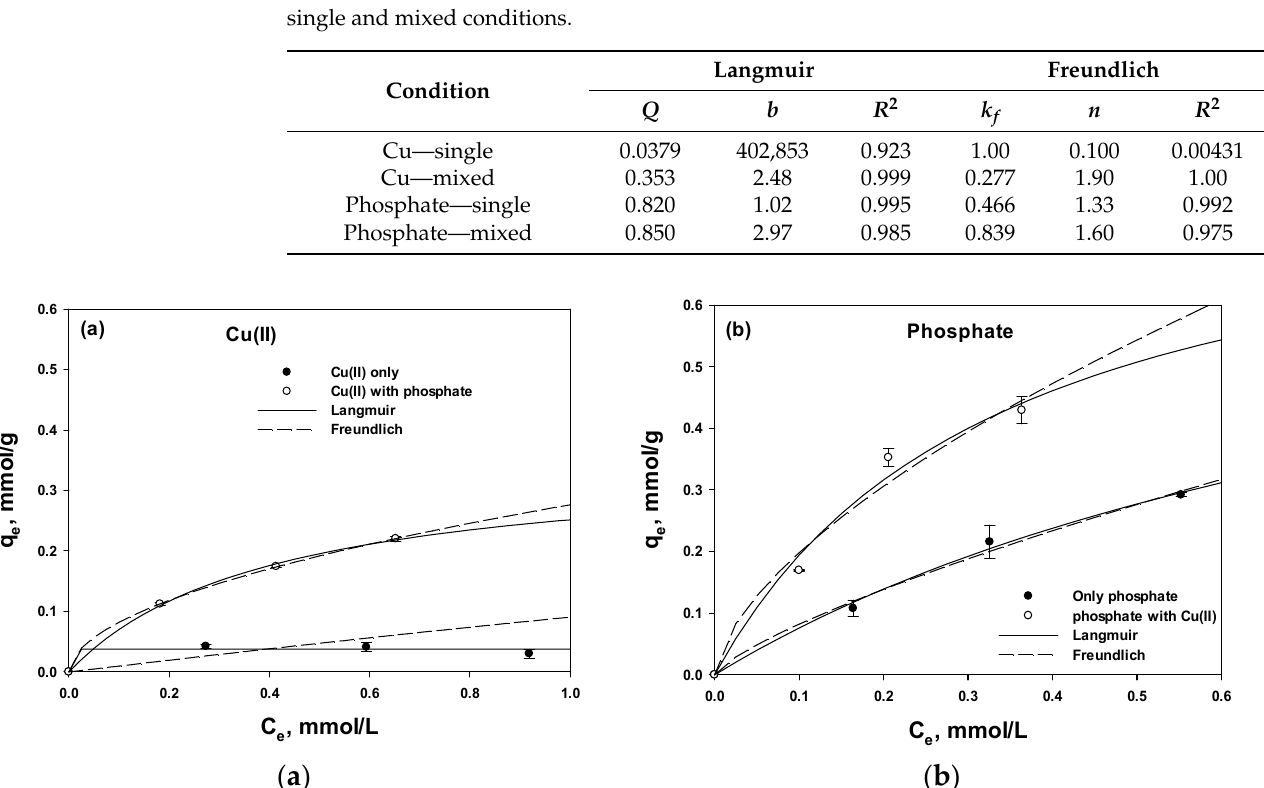
Figure 4. Langmuir and Freundlich isotherms for the adsorption of Cu(II) ( a ) and phosphate ( b ). Table 2. The parameters were calculated from Langmuir and Freundlich isotherm models under single and mixed conditions.